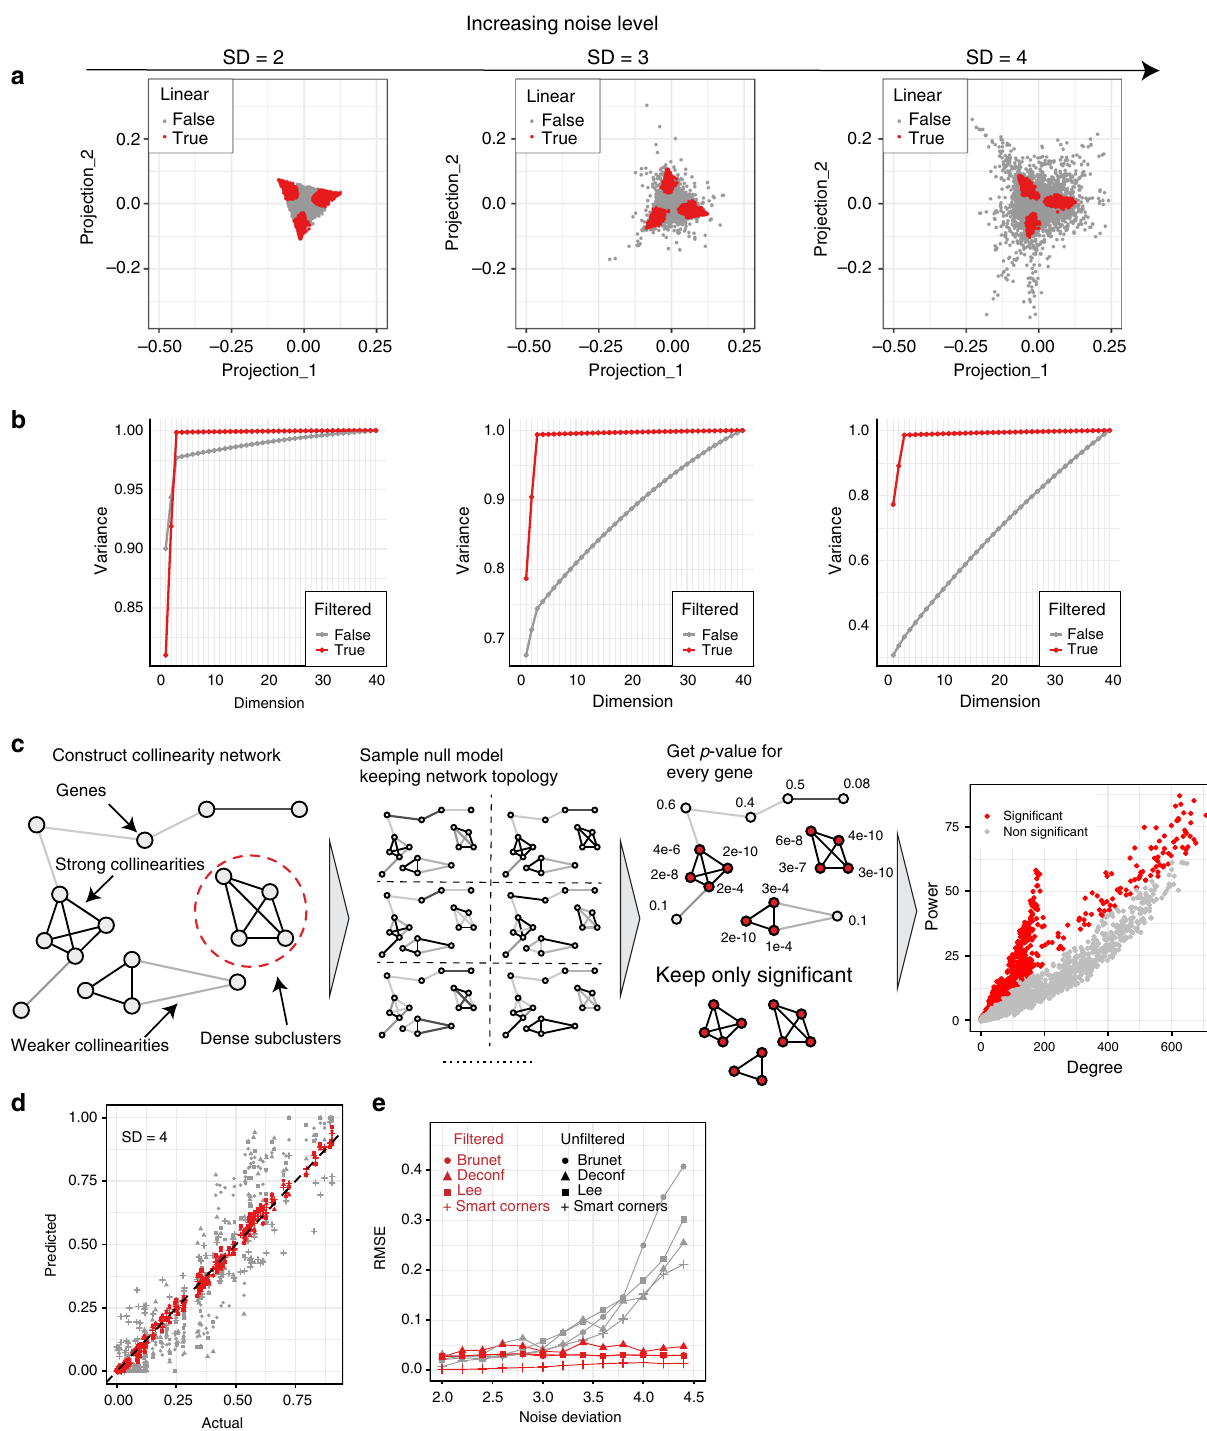
Fig. 5 Mutual linearity fi ltering improves deconvolution methods and allows cell type number identi fi cation in noisy cases. For panels a and b noise level is increasing from left to right. a Two-dimensional projection of simulation with noise. Points in red are selected by fi ltering procedure. b Variance explained by each SVD component for both un fi ltered (gray) and fi ltered (red) datasets. c Schematic for fi ltering approach. Collinearity network is built by calculating all the pairwise linearity coef fi cients and spearman correlations. When the network is built, weights of the edges are randomly shuf fl ed to test each gene to have more total weight than at random. We select only those genes with a signi fi cance level < 0.01. On the right is illustration of which genes are selected, where power denotes the sum of the weights of the edges. d For very noisy dataset linearity fi ltering improves performance of all complete deconvolution methods. e For different noise levels RMSE of predicted and actual proportions is